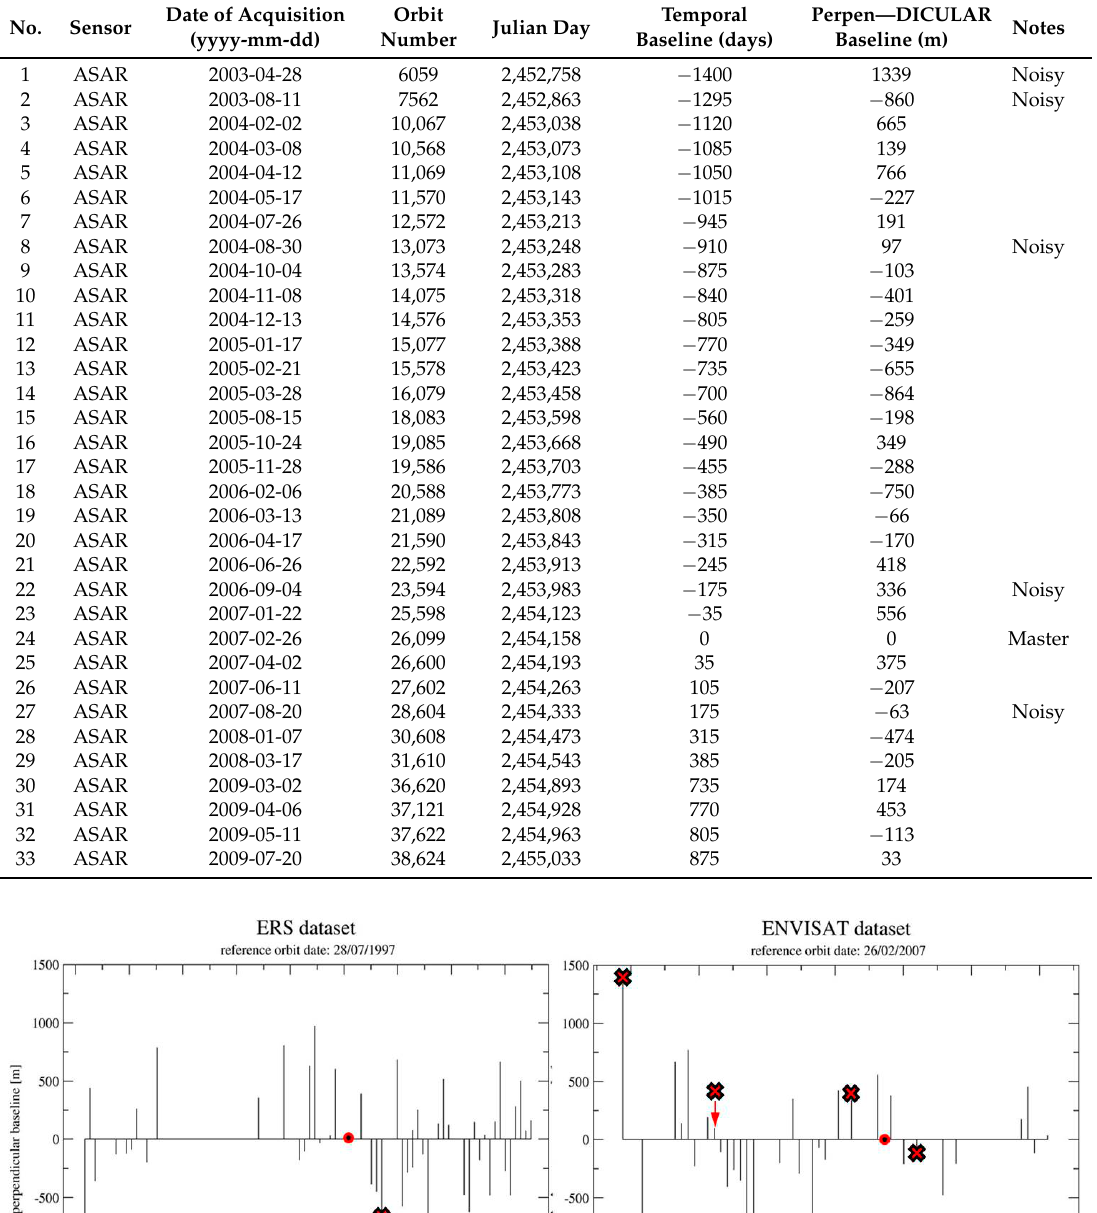
Table 2. ENVISAT dataset. Track 494, frame 2889 descending, swath I2. Images denoted in the NOTES column as noisy are those which have been removed from the final iteration due to the strong presence of atmospheric disturbances. Image denoted with MASTER is the reference images from which all the interferograms have been generated.